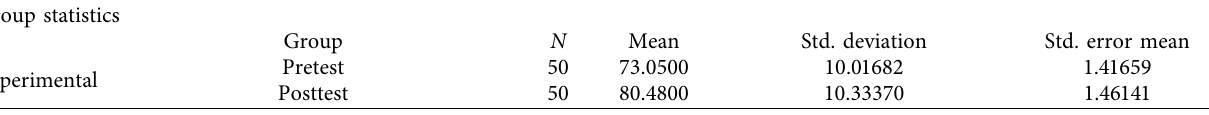
Table 4: Comparison of test results in the experimental class.